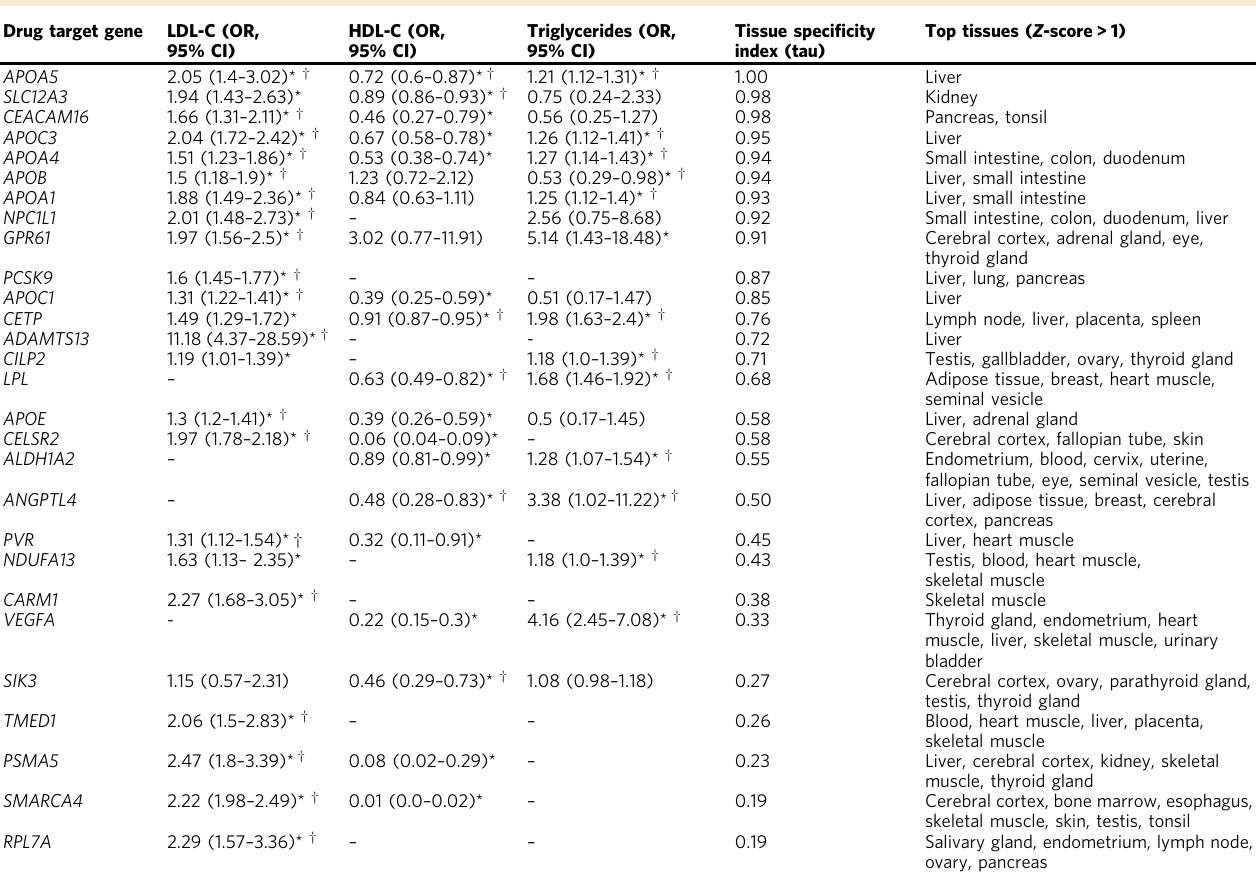
Fig. 3 Replication of drug target MR fi ndings. The discovery and replication analyses used different data sources for both exposure and outcome. Totally, 145 replication MR analyses were performed in which the gene boundaries included genetic associations exceeding the pre-speci fi ed signi fi cance threshold ( P value ≤ 1 × 10 − 4 ). Table 2 Tissue speci fi city for replicated genes encoding drug